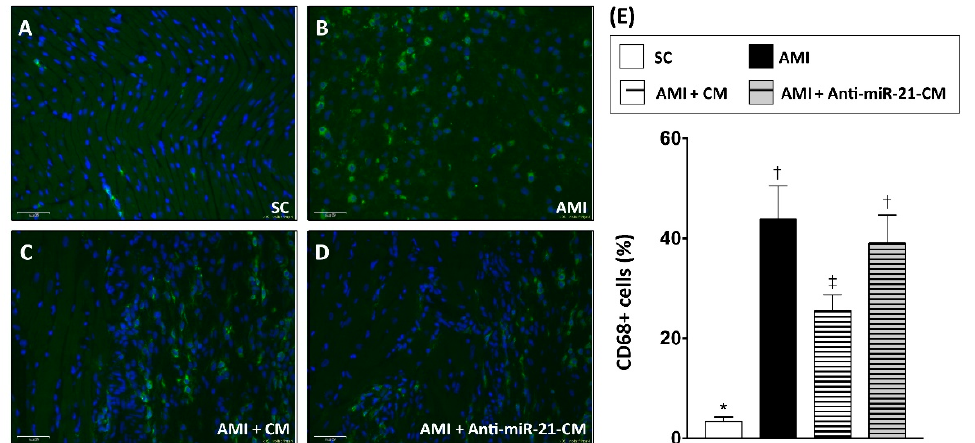
Figure 8. Inhibition of miR-21 reduced the e ff ect of conditioned medium on ameliorating myocardial infiltration of CD68 + macrophages. ( A ) Immunofluorescent staining to detect the distribution of CD68 + macrophages in sham control myocardial section. ( B ) Immunofluorescent staining to detect the distribution of CD68 + macrophages in myocardial section from rats with AMI induction. ( C ) Immunofluorescent staining to detect the distribution of CD68 + macrophages in myocardial section from rats with AMI induction and injection of conditioned medium derived from OGD-treated cardiomyocytes. ( D ) Immunofluorescent staining to detect the distribution of CD68 + macrophages in myocardial section from rats with AMI induction and injection of conditioned medium derived from OGD-treated cardiomyocytes with anti-miR-21 pre-transfection. ( E ) Calculation of CD68 + cells in myocardium. SC, sham control. AMI, acute myocardial infarction. CM, conditioned medium derived from OGD-treated cardiomyocyte. Anti-miR-21-CM, conditioned medium derived from cardiomyocyte pre-transfected with anti-miR-21 (20 nM). Groups with di ff erent symbols (*, † , ‡ ), p < 0.05. n = 8 for each group. Scale bar in left lower corner indicates 50 μ m.